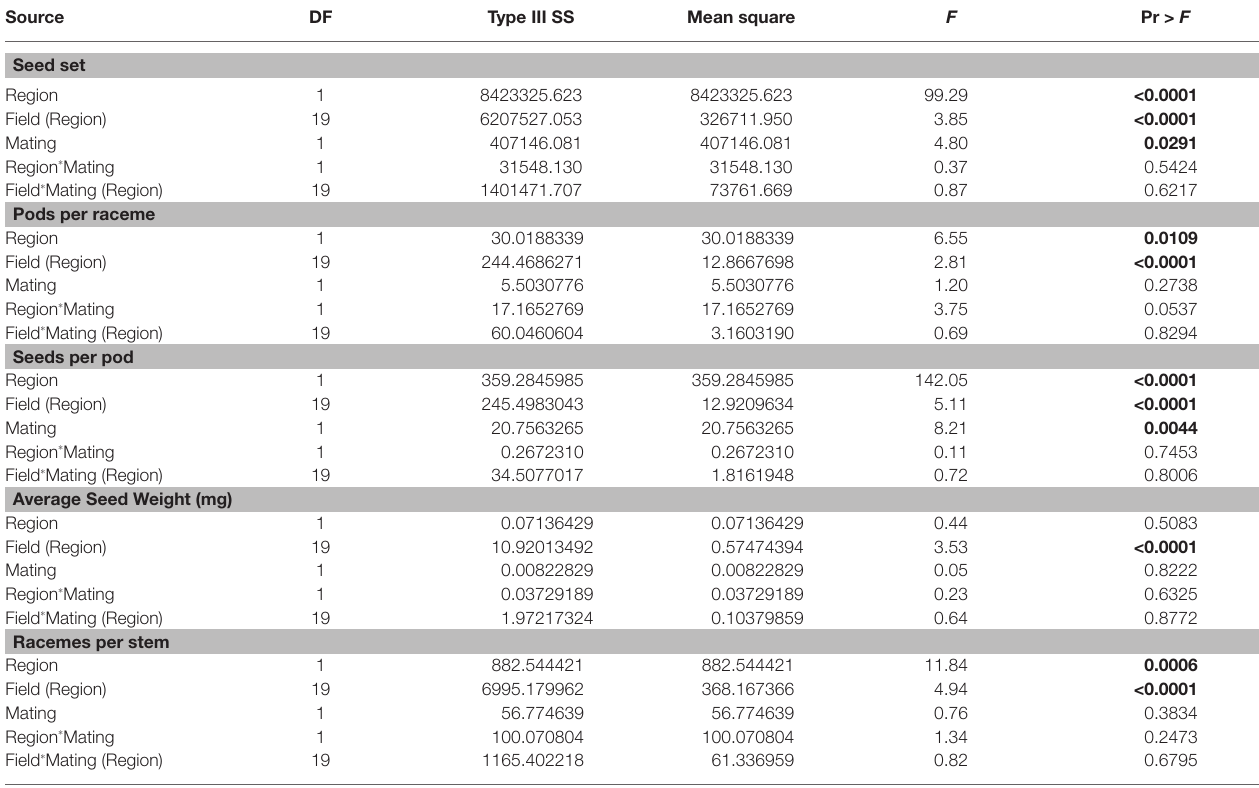
TABLE 3 | The impact of region (CEV and IMP), field within region, and mating system (selfed or outcrossed) on each seed yield metric, based on a three-way ANOVA. Source DF Type III SS Mean square F Pr > F